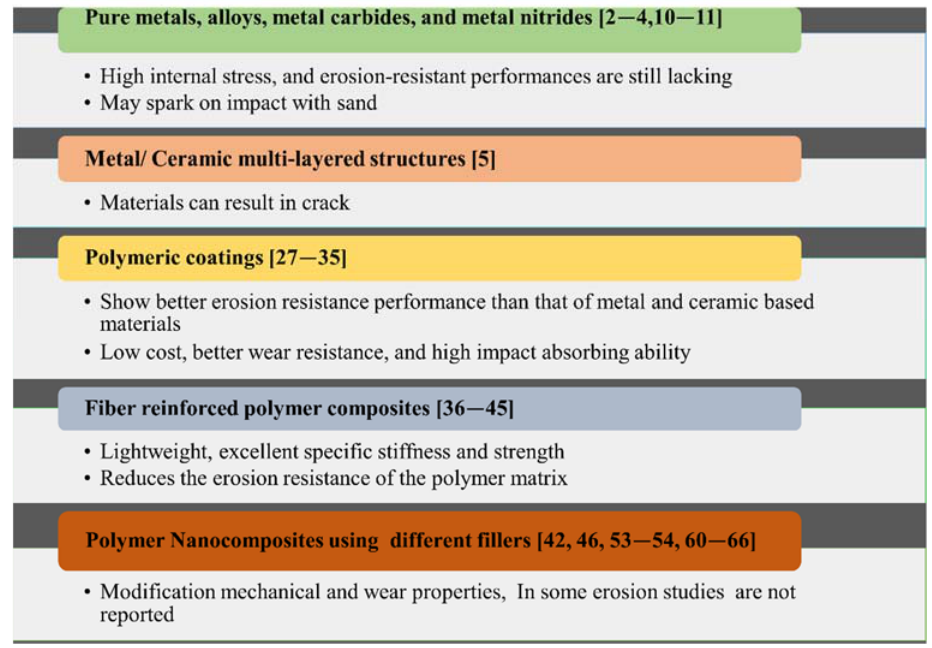
Figure 3. Historical utilization of materials for surface protection.